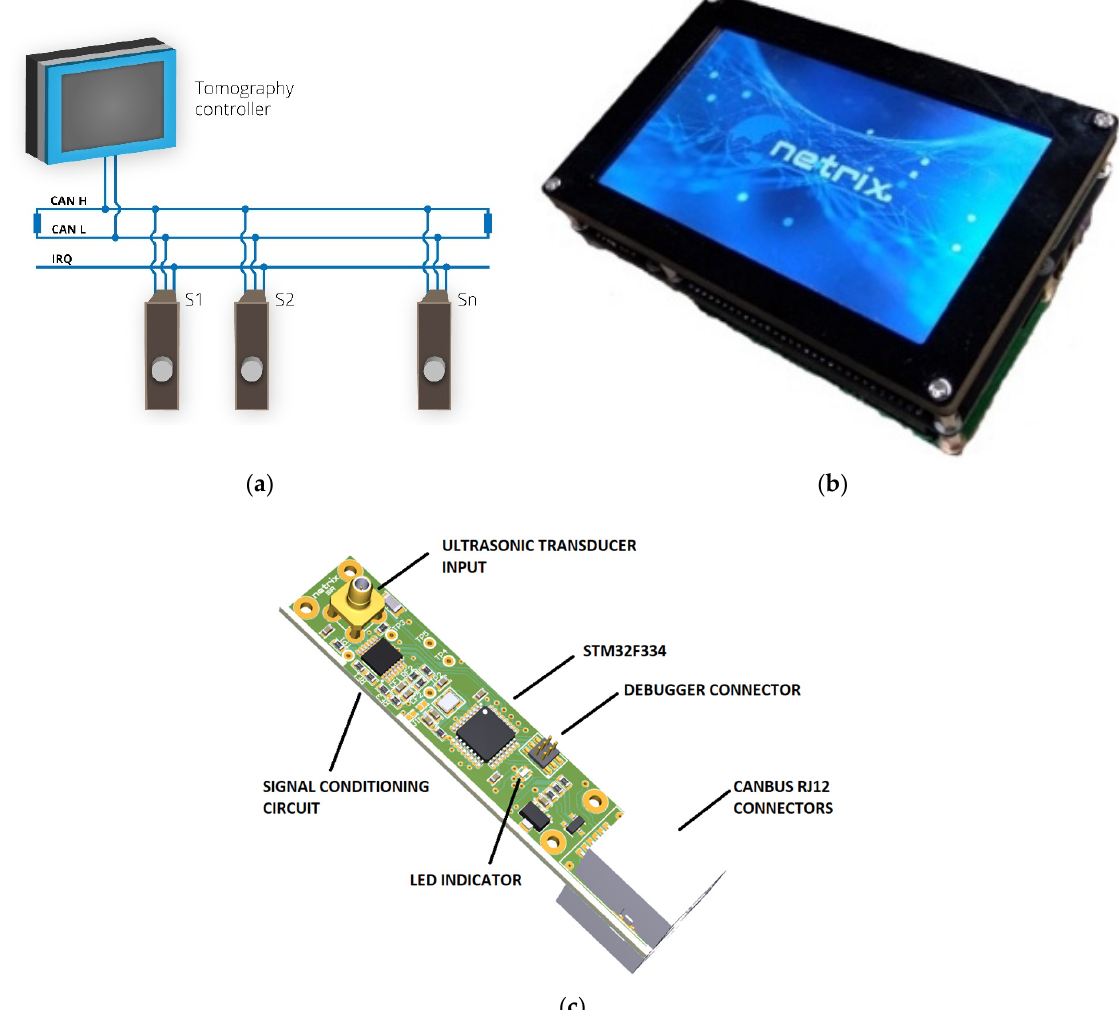
Figure 4. Ultrasound tomography device: ( a ) block diagram, ( b ) start-up control module, ( c ) active measuring transducer.